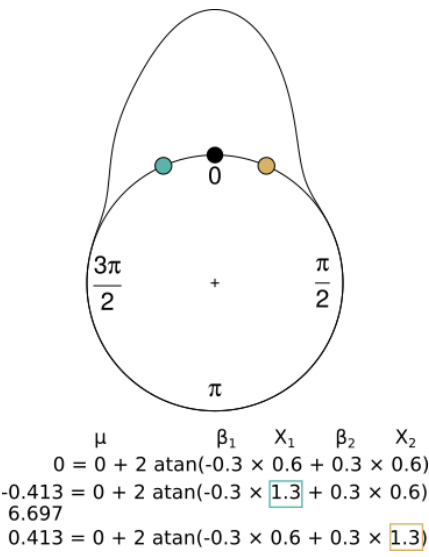
Figure 2. Interpretation of the coefficients in the circular regres- sion considering a reference point (black) generated with a circular– linear model with mean angular direction ( µ = 0), two coefficients ( β 1 , β 2 ) and two variables ( x 1 , x 2 ), where one of the coefficients is negative ( β 1 ), and the other one is positive ( β 2 ). When the coeffi- cient is negative and the value of the parameter increases (blue), the result is an earlier observation compared with the reference point (the equivalent of − 0 . 413rad is 6.697rad, as is shown below the equation). On the other hand, when the coefficient is positive and the variable increases (yellow), the observation is